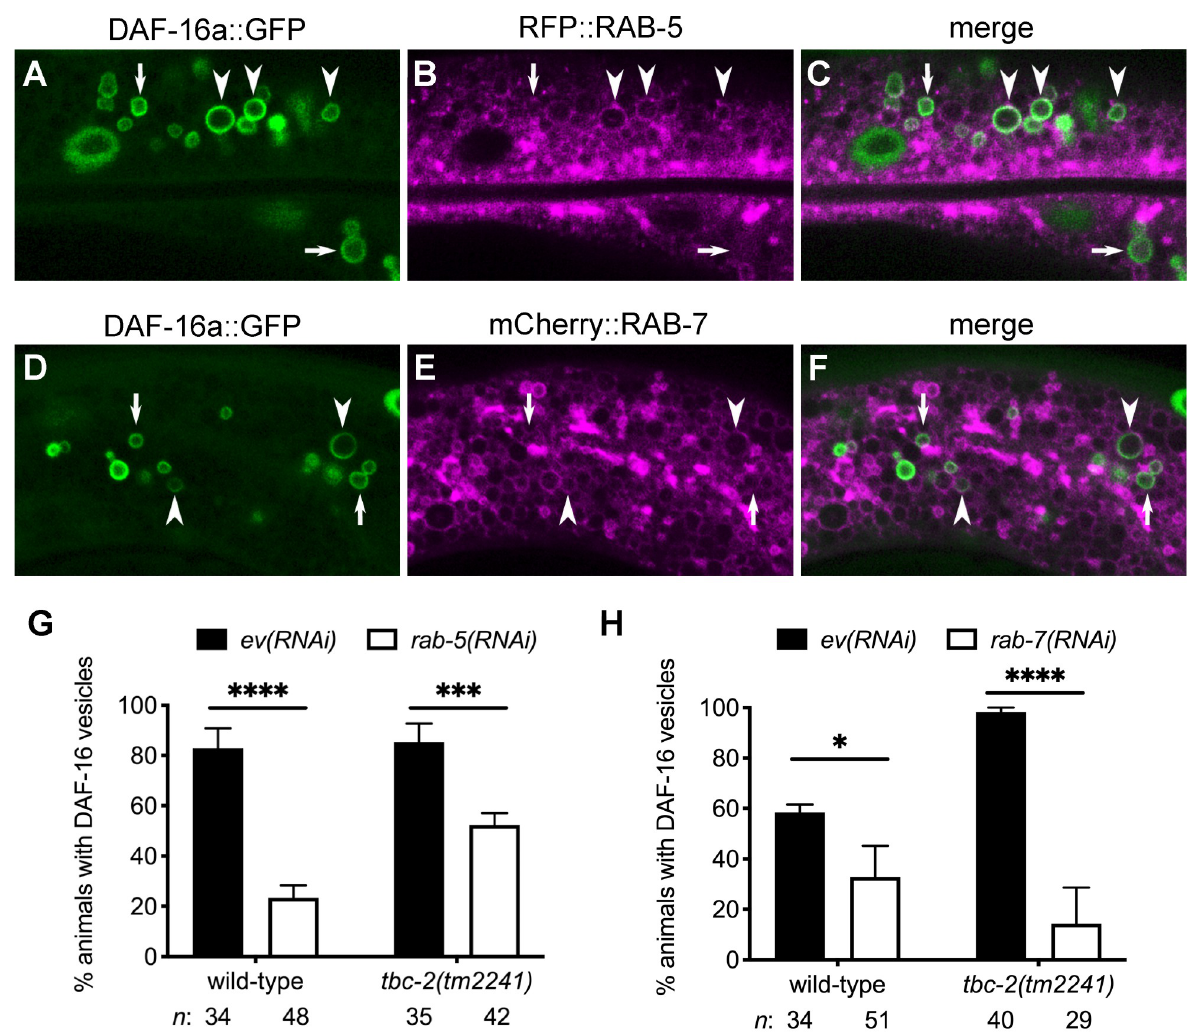
Fig 3. RAB-5 and RAB-7 GTPases promote DAF-16 FOXO localization to endosomes. (A-F) Representative confocal images of the intestinal cells of animals expressing DAF-16a::GFP ( zIs356) (green) and either RFP::RAB-5 ( pwIs480 ) (A-C) or mCherry::RAB-7 ( pwIs429 ) (magenta) (D- F). Arrowheads mark examples of vesicles positive for both DAF-16a::GFP and either RFP::RAB-5 or mCherry::RAB-7. Arrows mark examples of DAF- 16a::GFP vesicles that are not positive for either RFP::RAB-5 or mCherry::RAB-7. (G and H) Bar graphs displaying the mean (and SEM) of the percent wild-type and tbc-2(tm2241) animals with DAF-16a::GFP ( zIs356 ) vesicles fed bacteria expressing control empty vector (ev) RNAi (black bars) compared to animals fed rab-5(RNAi) or rab-7(RNAi) (white bars) from three independent experiments. Raw data is available in S1 Data. Fisher’s exact test (graphpad.com) was used to determine the statistical difference between conditions. n , total number of animals. � P < 0 . 05 , ��� P < 0 . 001 , ���� P < 0 . 0001